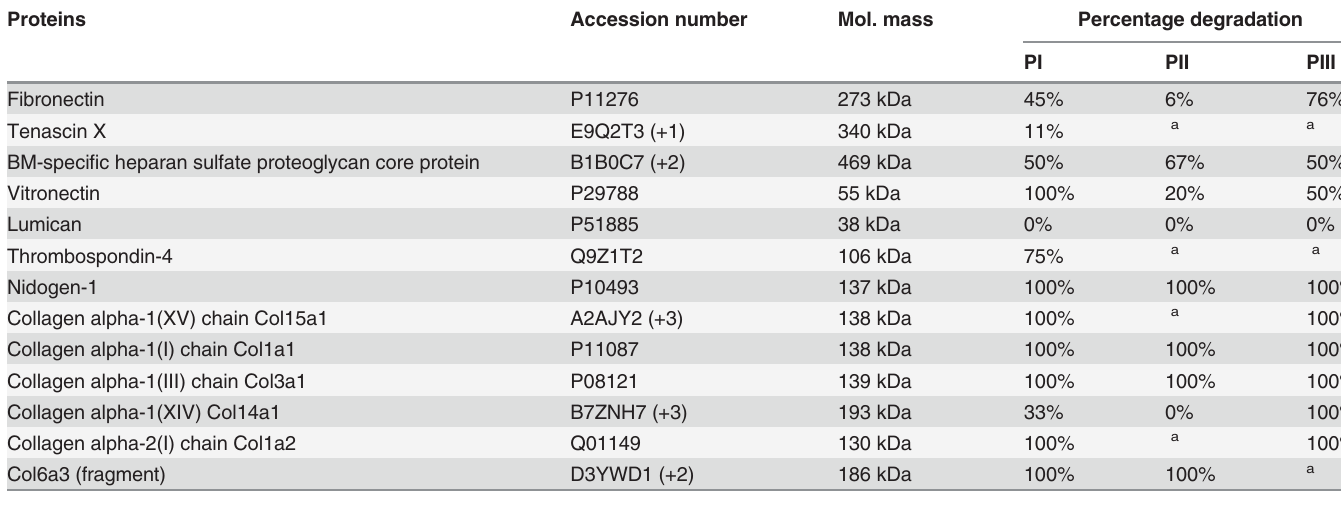
Table 3. Degradation of extracellular matrix proteins identified in wound exudates (see Methods section for details).